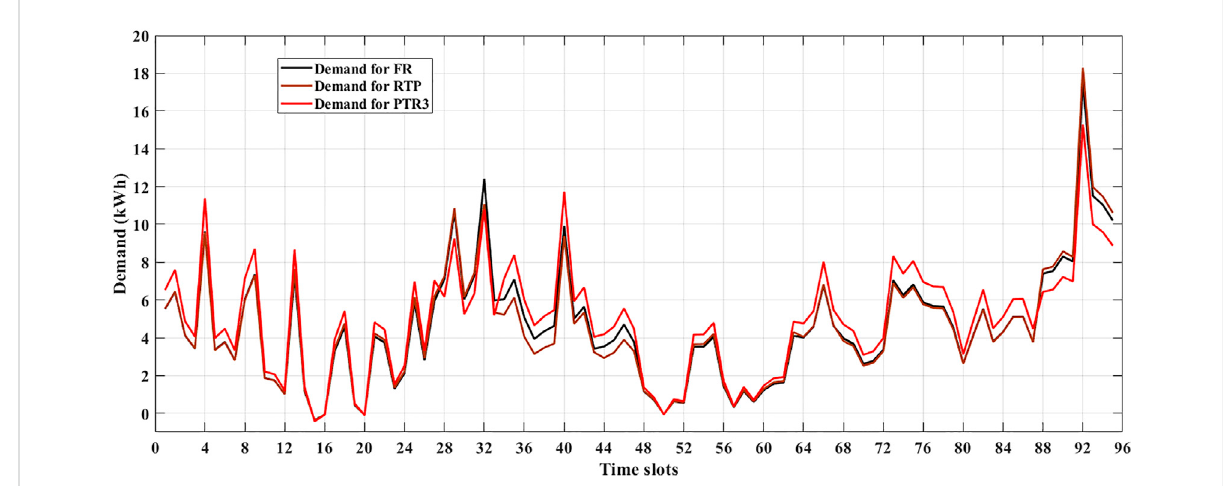
FIGURE 7 Demand curve of all pricing schemes for February 05.